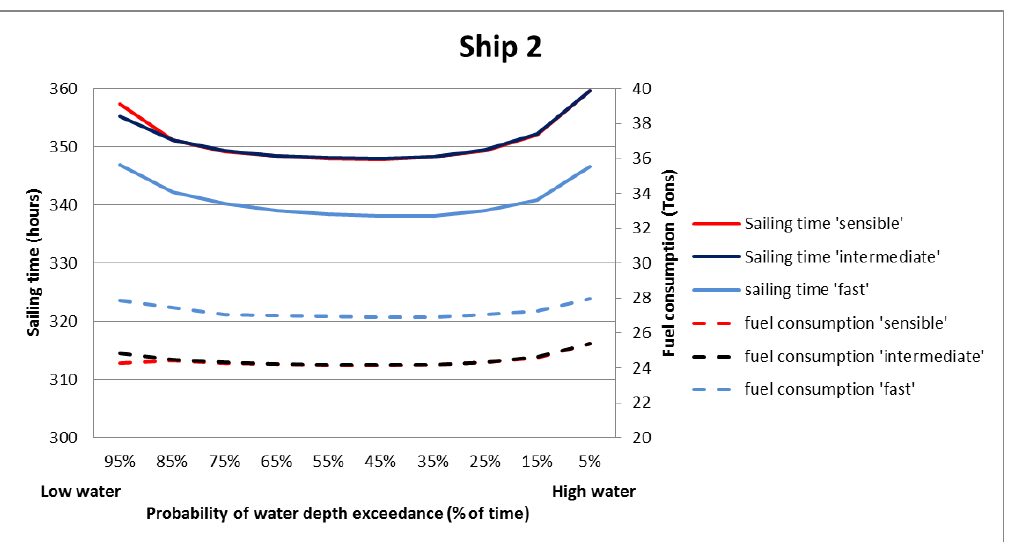
Figure 9. Impact of sailing strategies on fuel consumption and sailing times - ship 2